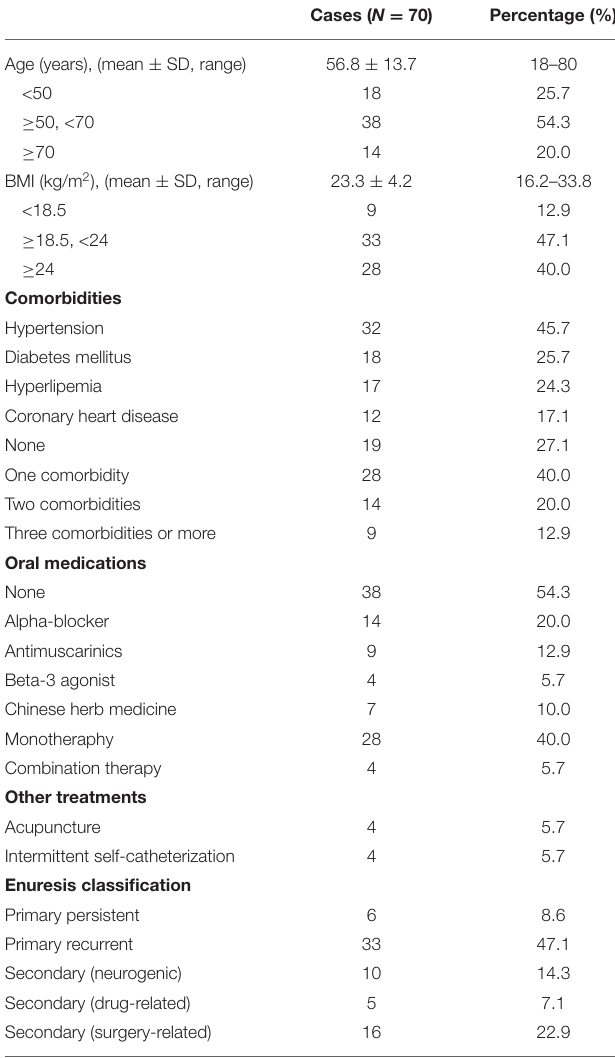
TABLE 1 | The demographic data of adult women with